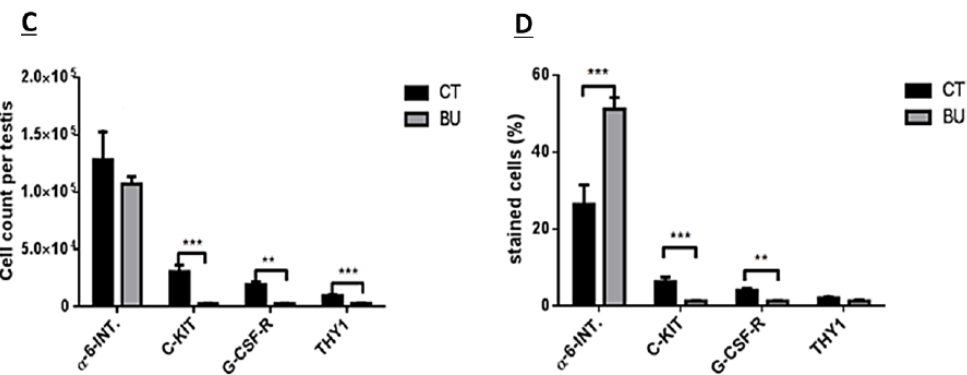
Figure 4. Effect of 10-day post busulfan (BU) treatment on spermatogonial cell counts and percentages, as examined by fluorescence-activated cell sorter (FACS) analysis, as follows: BU or DMASO (control, CT) were i.p injected, as described in Figure 1. Ten days after the injection, the testes were removed, seminiferous tubules were separated, and the cells were enzymatically isolated from the seminiferous tubules. Spermatogonial cells with the membrane markers: alpha-6-INTEGRIN (alpha-6-INT), c-KIT, G-CSF-R, and THY1 were identified by FACS using specific antibodies for each marker ( A ). Spermatogenic cells were identified by immunofluorescence staining for specific markers [premeiotic (CD9, VASA, and SALL4), meiotic (CREM, BOULE, and ACROSIN), and postmeiotic (ACROSIN)] ( B ). The above identified spermatogonial cells were counted and calculated per testicle ( C ), and their percentage was evaluated ( D ). ** p < 0.01 and *** p < 0.001.